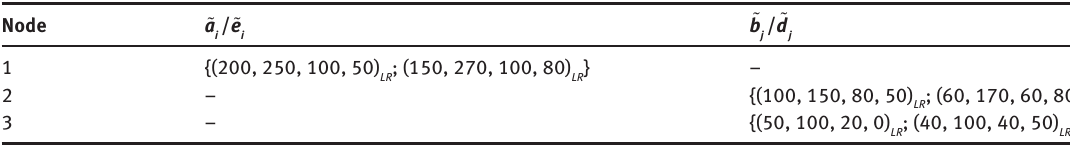
a e (cid:31) (cid:31) and Intuitionistic Fuzzy Demand ( / ). i i